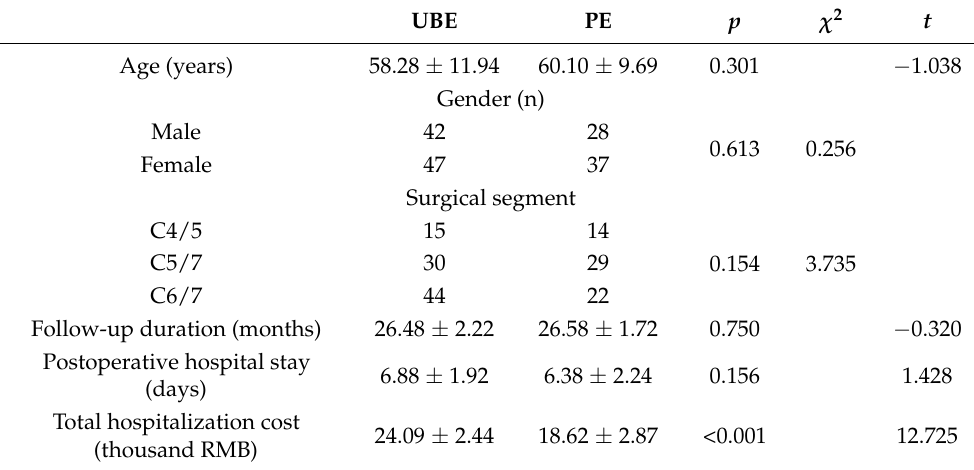
Table 1. Patient Characteristics.